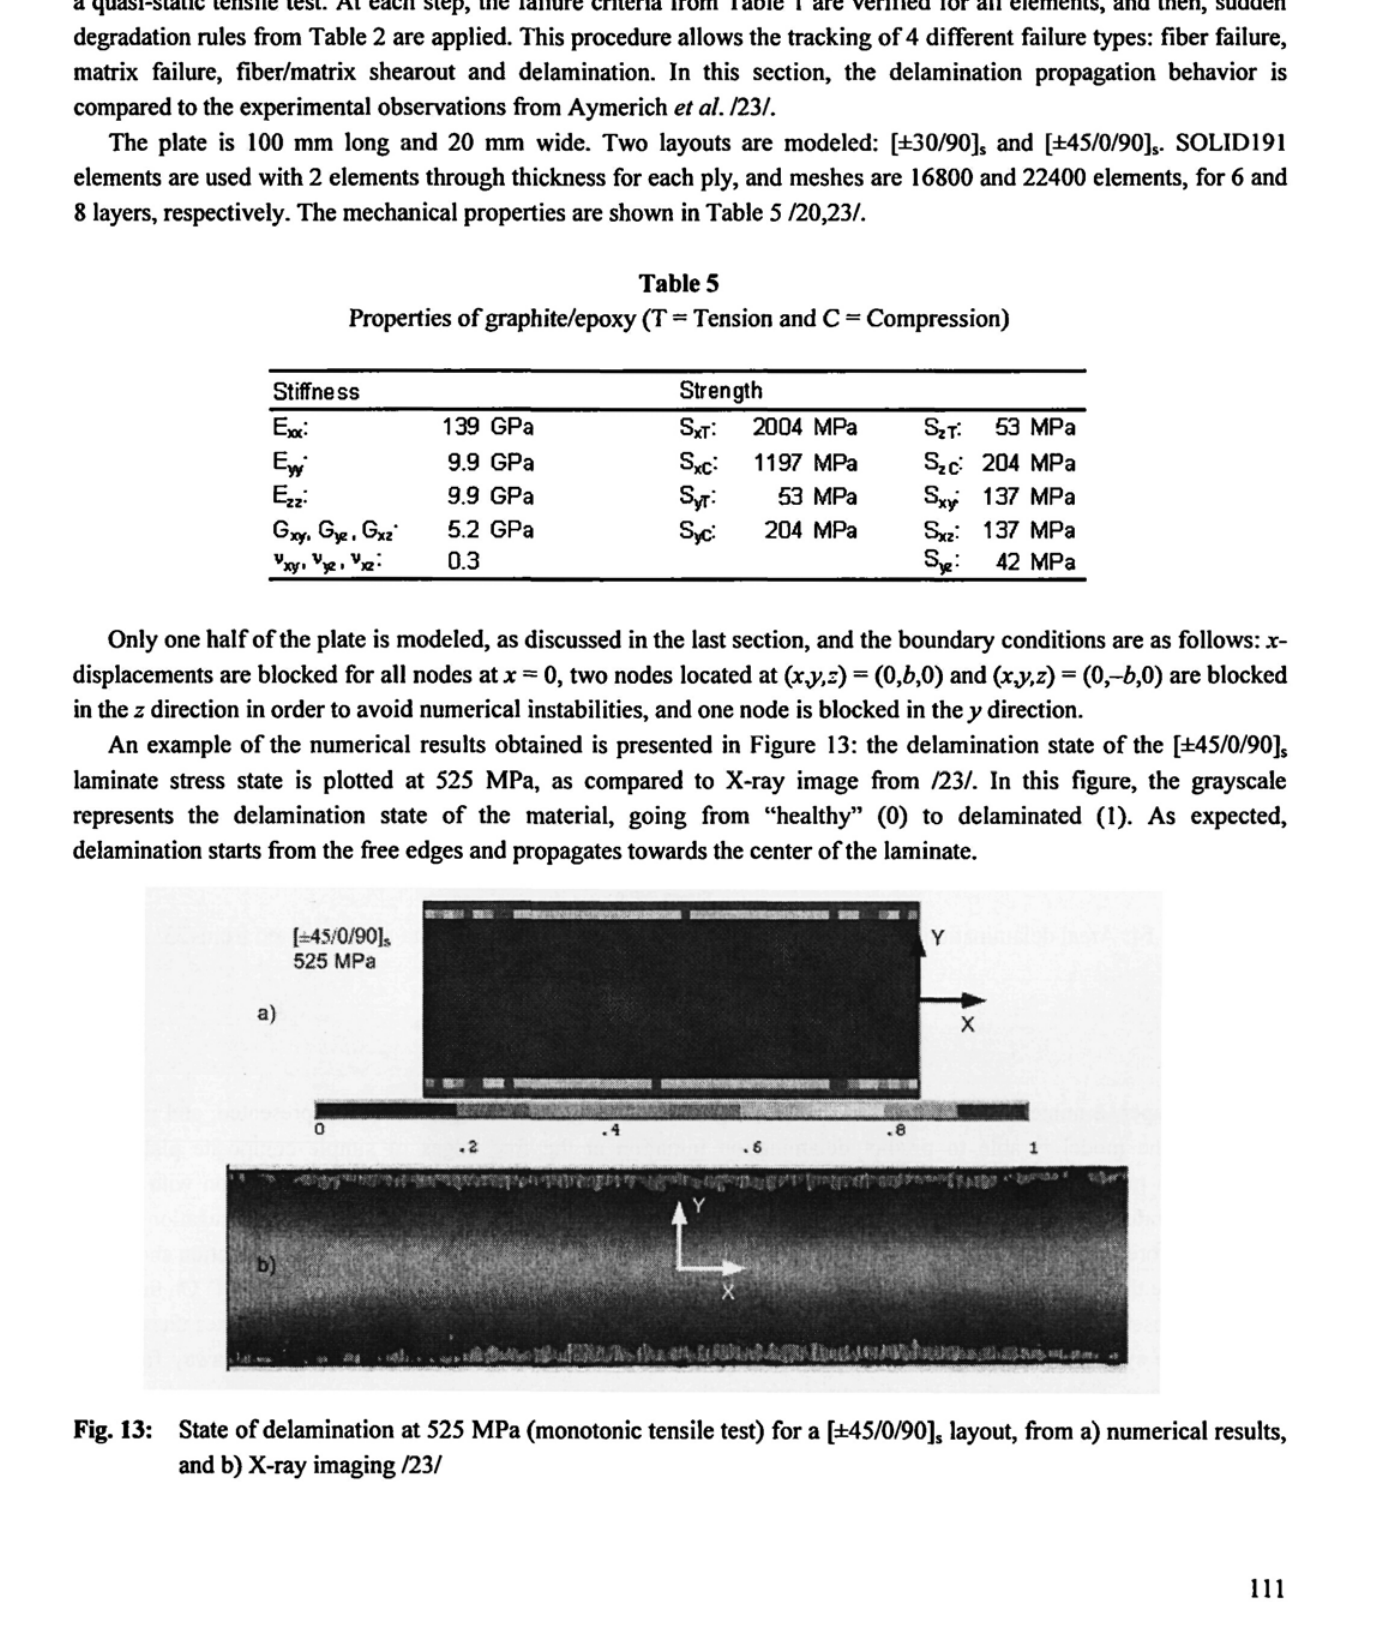
State of delamination at 525 MPa (monotonic tensile test) for a [±45/0/90] and b) X-ray imaging